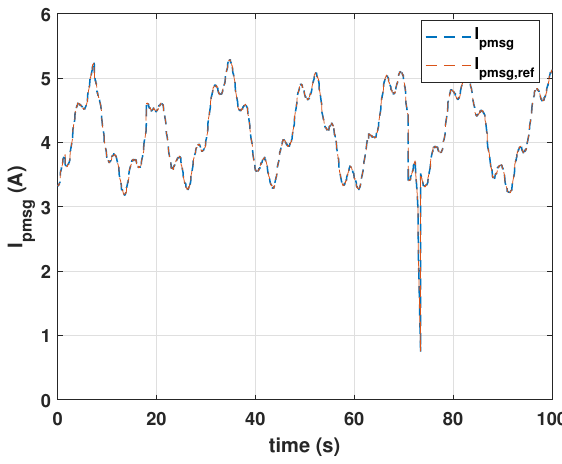
Figure 15. Output current of the PMSG.